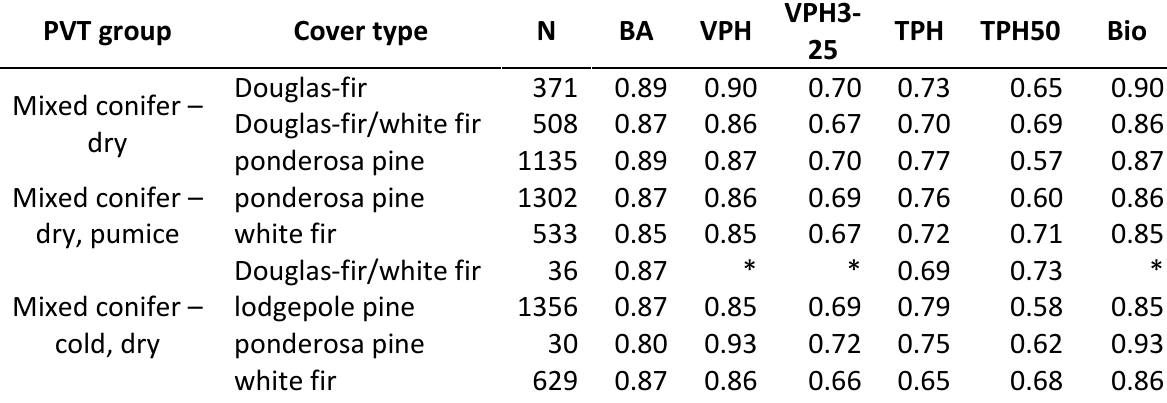
Table A7. Adjusted r-squared values from best models of forest structure attributes regressed on stand age, quadratic mean diameter, canopy cover, and number of canopy layers. Attributes: sample size (N), total basal area (BA, m 2 /ha), bole volume (VPH, m 3 /ha), bole volume of